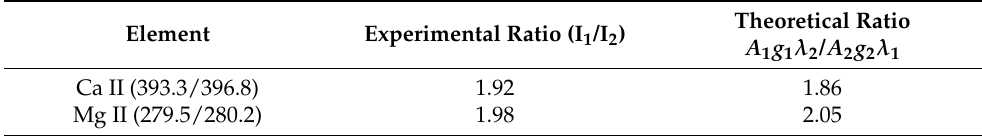
Table 2. Experimental and theoretical ratio of the spectral line Ca II and Mg